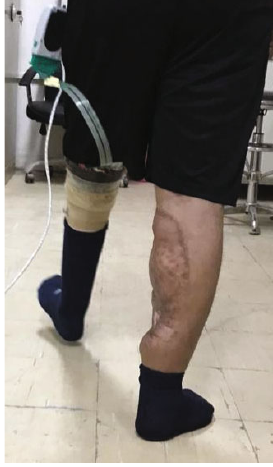
Figure 4: Patient with a MatScan sensor.